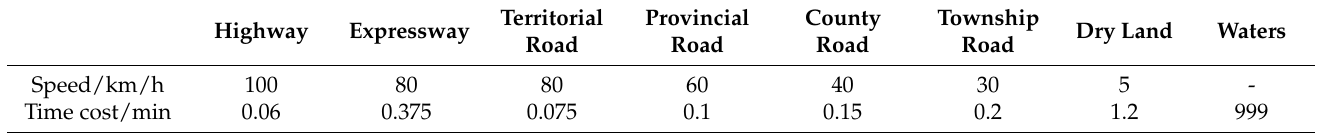
Table 4. Time cost assignment of production and living space elements based on road and land type.